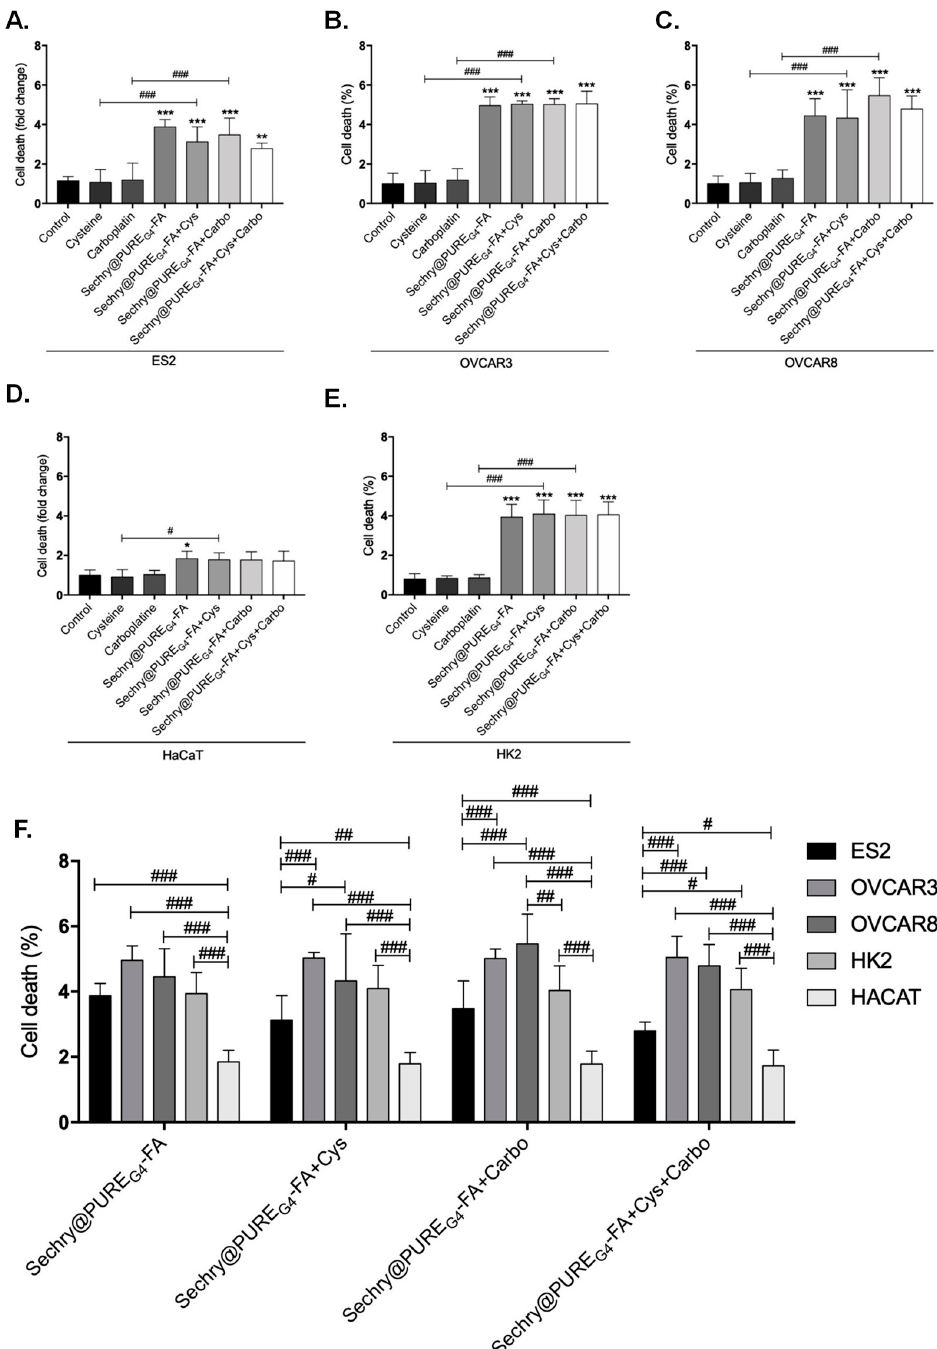
Figure 6. SeChry and folate-targeted polyurea dendrimer generation four (SeChry@PURE G4 -FA) nanoparticles increase specificity to ovarian cancer cells. All cell lines (ES2, OVCAR3, OVCAR8, HaCaT, and HK2) were exposed to DMSO (control), cysteine, carboplatin, SeChry@PURE G4 -FA, and SeChry@PURE G4 -FA combined with cysteine and / or carboplatin for 24 h and 48 h of SeChry@PURE G4 -FA exposure ( A – E ). Cell death was analyzed by flow cytometry using annexin V–FITC and propidium iodide (PI) staining. SeChry@PURE G4 -FA and SeChry@PURE G4 -FA combined with cysteine and / or carboplatin conditions were compared between cell lines ( F ). Results are shown as means ± SD; * p < 0.05, ** p < 0.01, *** p < 0.001, and represents statistical significance in relation to control conditions, and # p < 0.05, ## p < 0.01, ### p < 0.001represents statistical significance between conditions (one-way ANOVA, Tukey post-test).